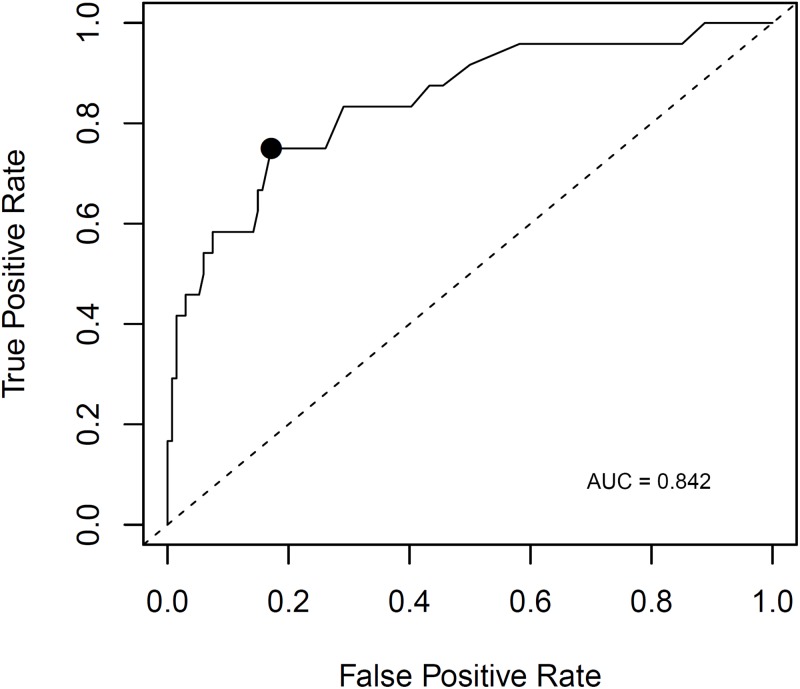
Receiver operating characteristic (ROC) curve, ACR 0R versus ACR 1R+2R+3R.Area under the Curve (AUC) was a robust 0.842. Using the DF cutoff of 0.32%, NPV for grade 2R or higher ACR, the intended use of the myTAIHEART assay, was 100.00% for grade 2R or higher ACR, with 100.00% sensitivity and 75.48% specificity.